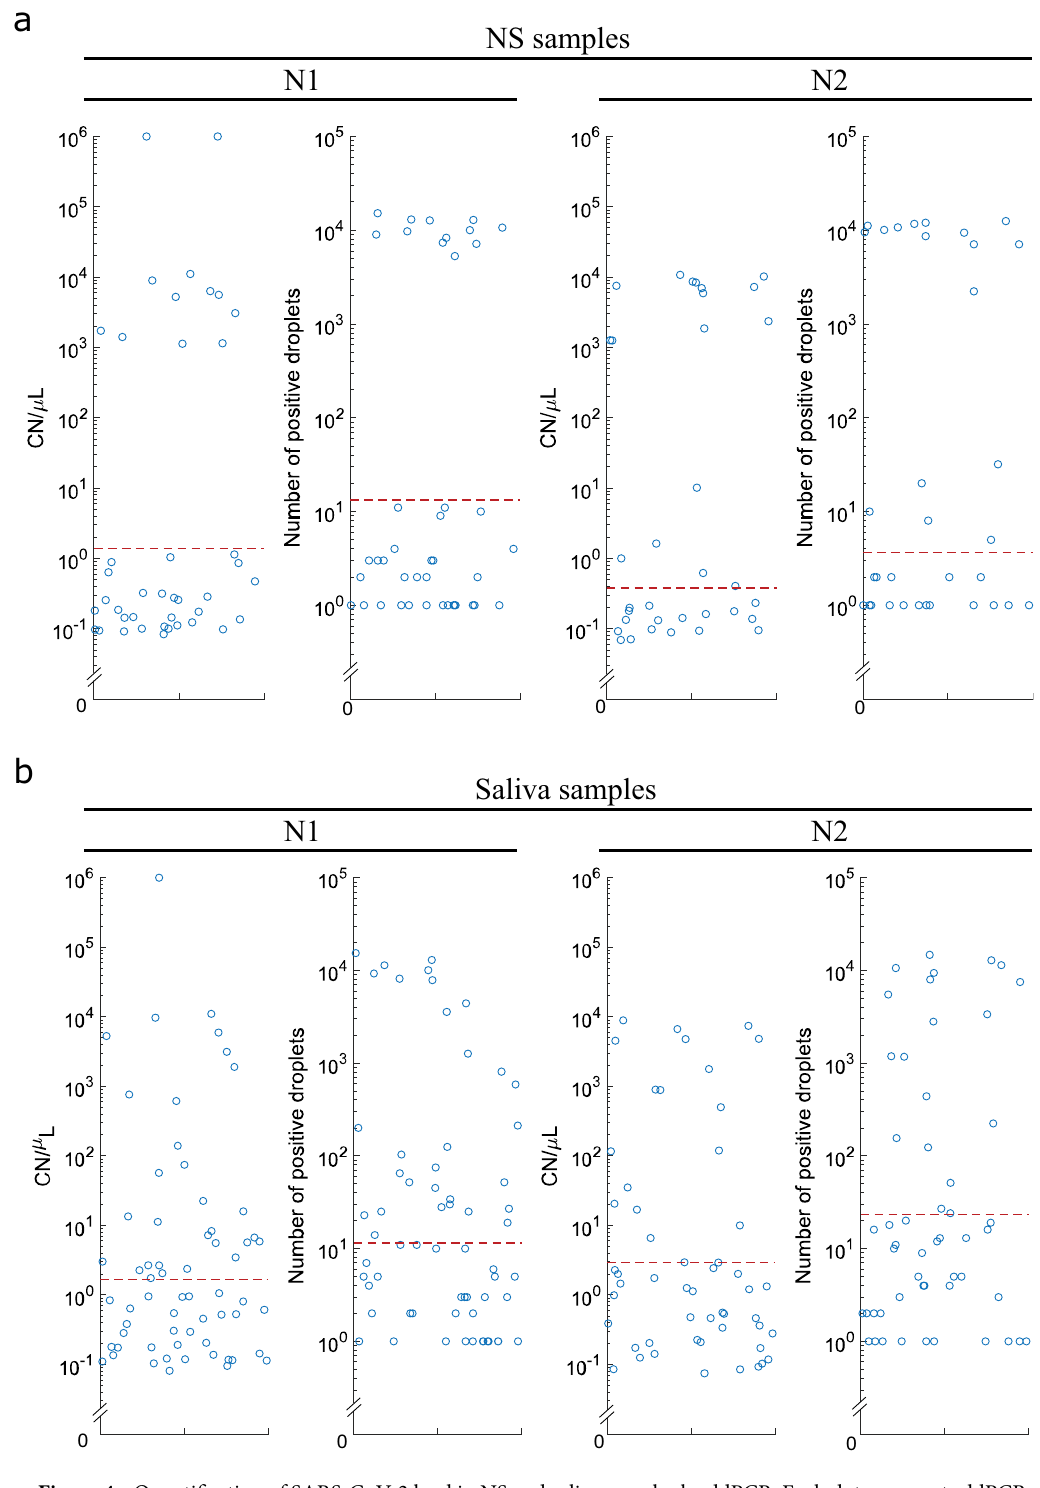
Figure 4. Quantification of SARS-CoV-2 load in NS and saliva samples by ddPCR. Each dot represents ddPCR results from distinct nasal swab ( a ) or saliva specimen ( b ) collected from 92 patients with reported symptoms at the curbside testing facility. Red dashed lines indicate ddPCR thresholds calculated using measurements from 45 SARS-CoV-2 negative and asymptomatic individuals (pre-operative cohort). Droplets with concentration/ counts above the threshold were determined as SARS-CoV-2